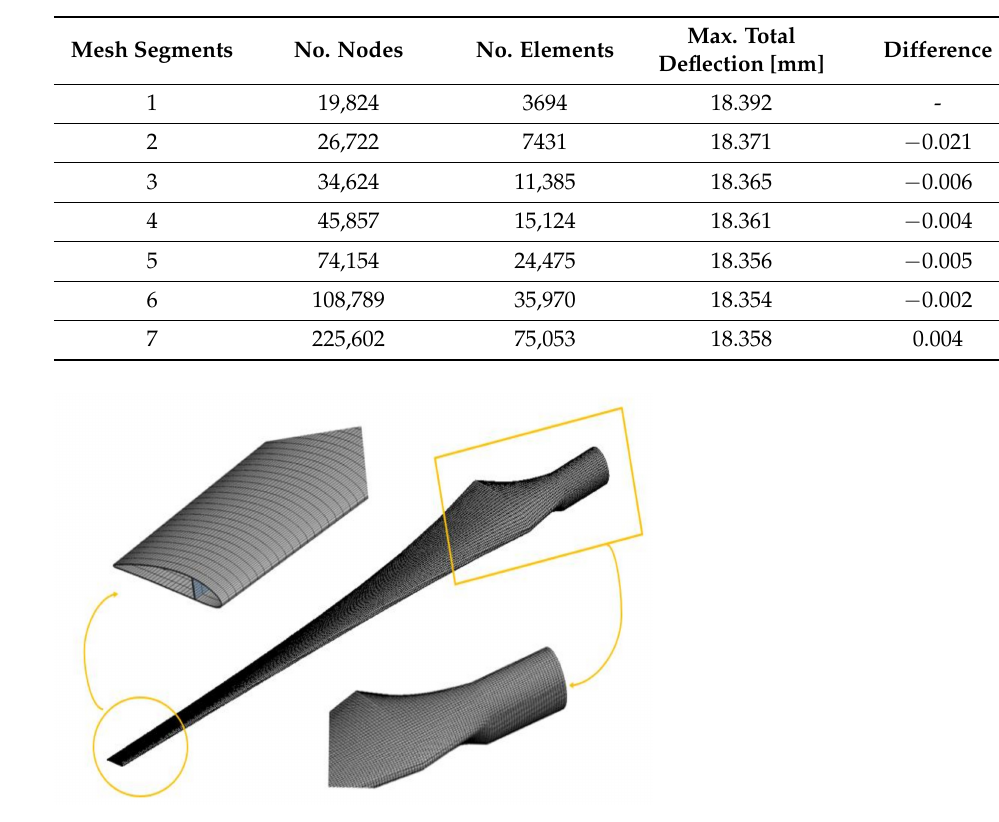
Table 5. The mesh convergence of wind turbine blade.